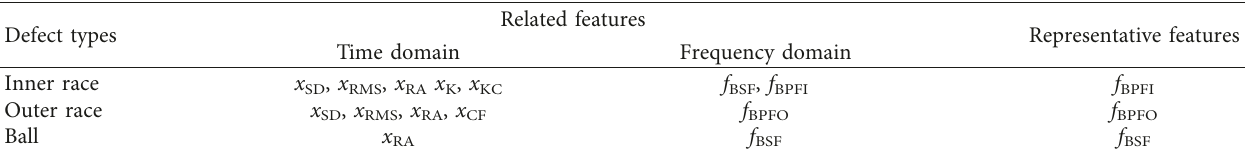
Figure 6: Three bearing failures in different fault sizes. (a) Inner race, (b) ball, and (c) outer race. Table 6: Representative features of different